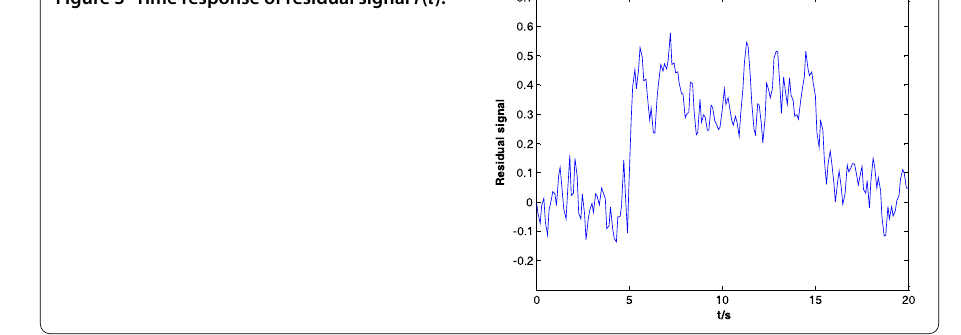
Figure 3 Time response of residual signal r ( t ).